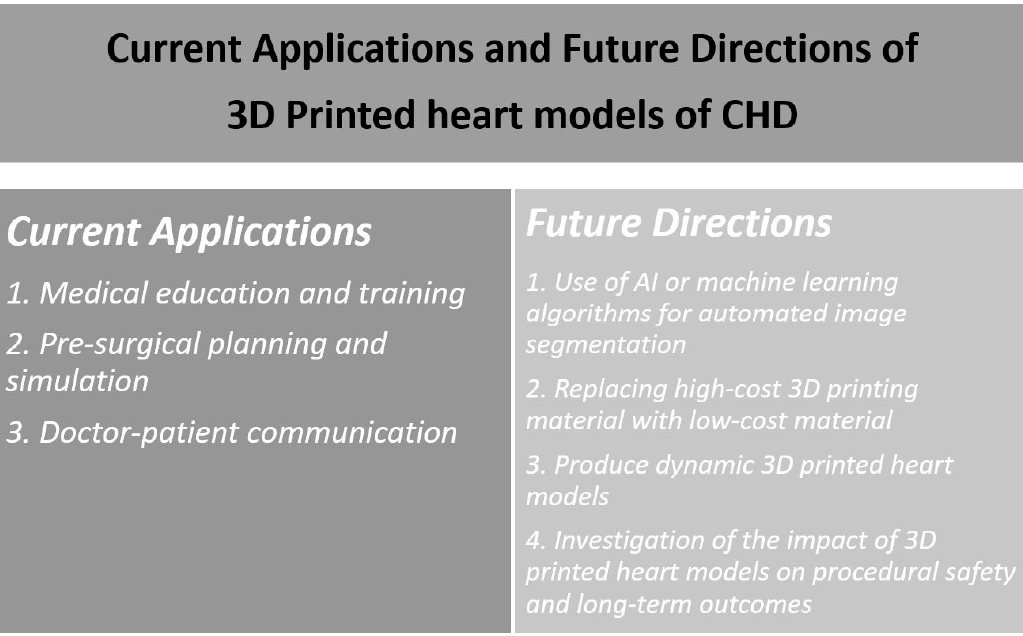
Figure 11. Summary of current applications and future research directions of 3D printing in congenital heart disease. 3D—three-dimensional; CHD—congenital heart disease; AI—artificial intelligence.